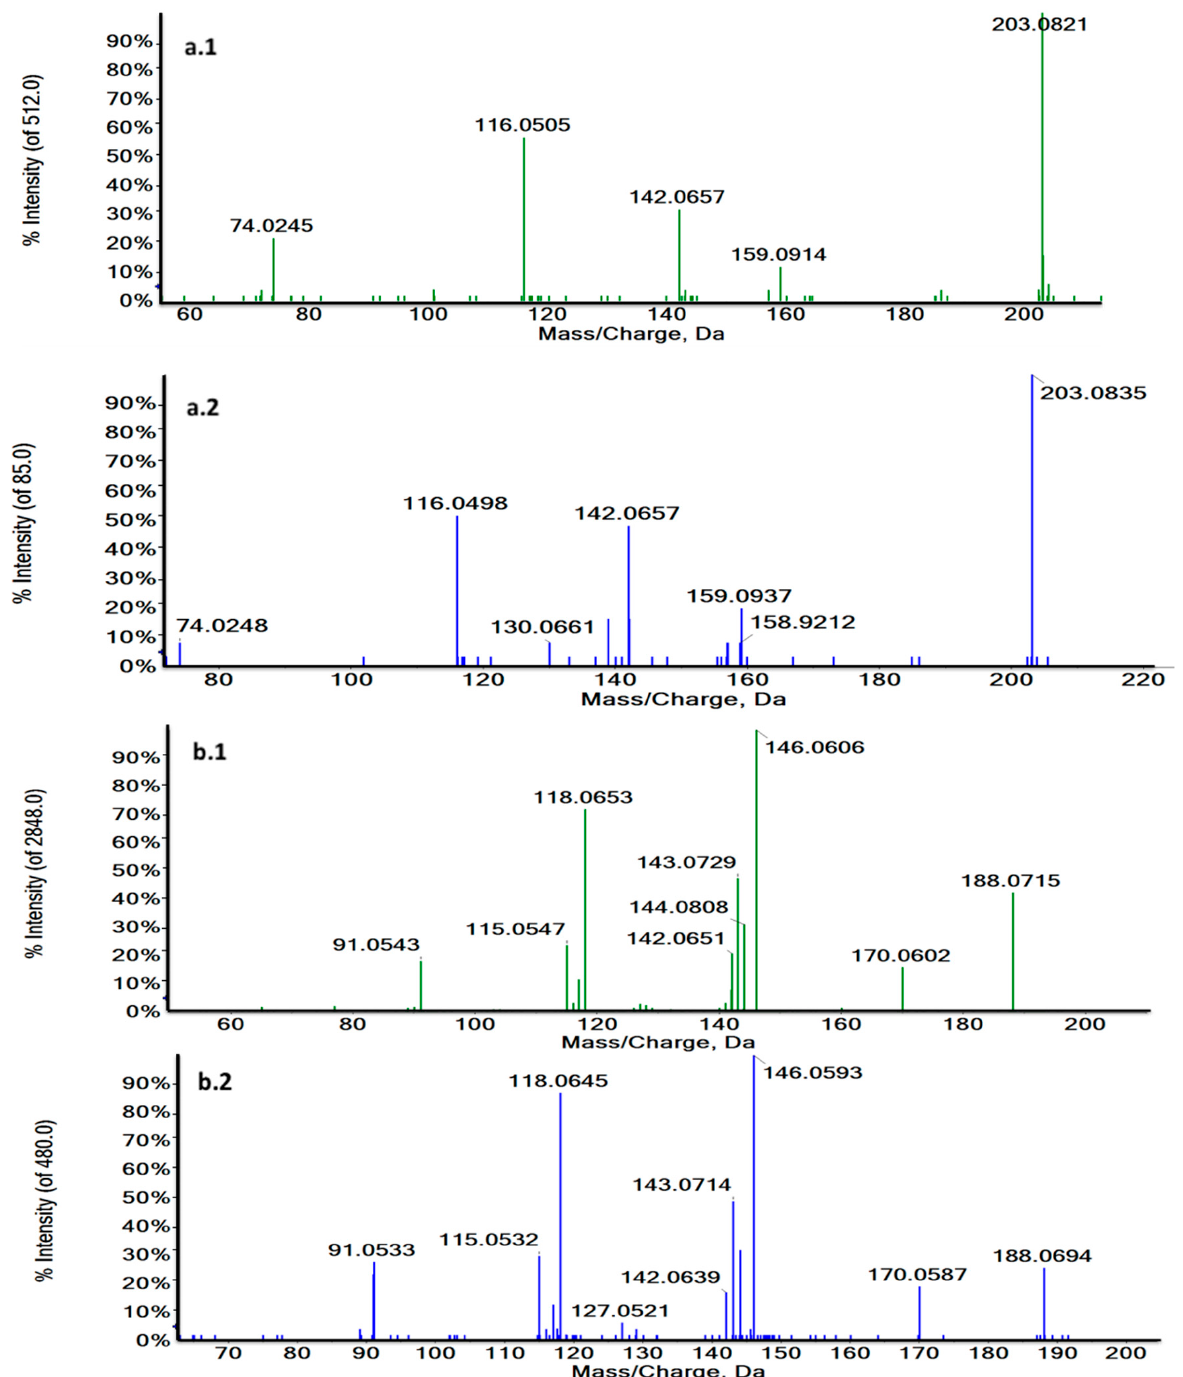
Figure 4. Characteristic MS/MS spectra of m/z 188.0707 in a biological sample (green) ( a.1 ) and the L-Tryptophan standard at 3.73 min in ESI + (blue) ( a.2 ) and m/z 203.0824 at 1.27 min in a biological sample (green) ( b.1 ) and the L-Tryptophan standard in ESI − (blue) ( b.2 ). MS/MS spectra revealed the characteristic fragmentation pattern of L-Tryptophan both in ESI+ and ESI − .